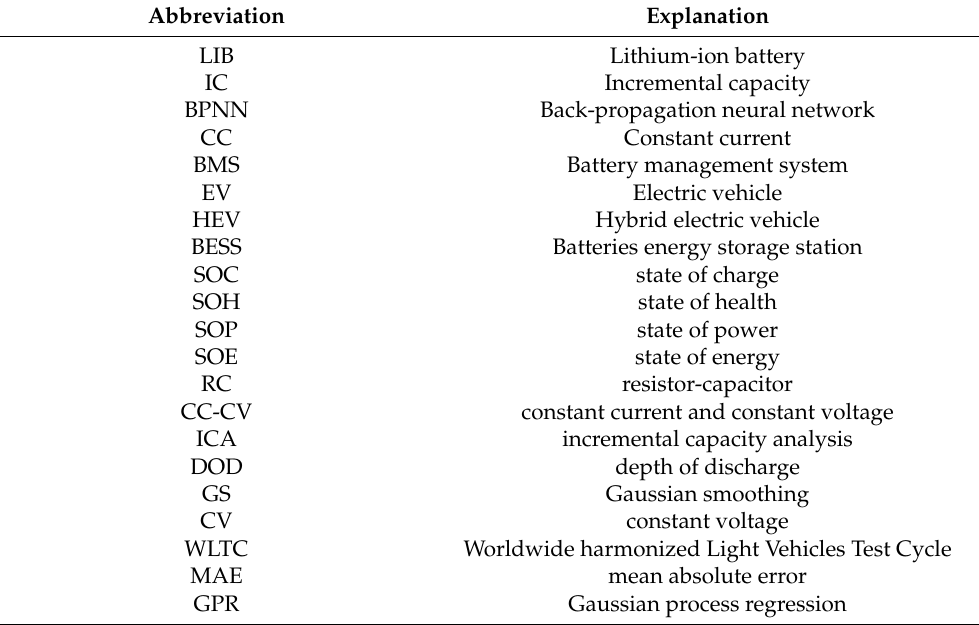
Table A1. Abbreviation comparison